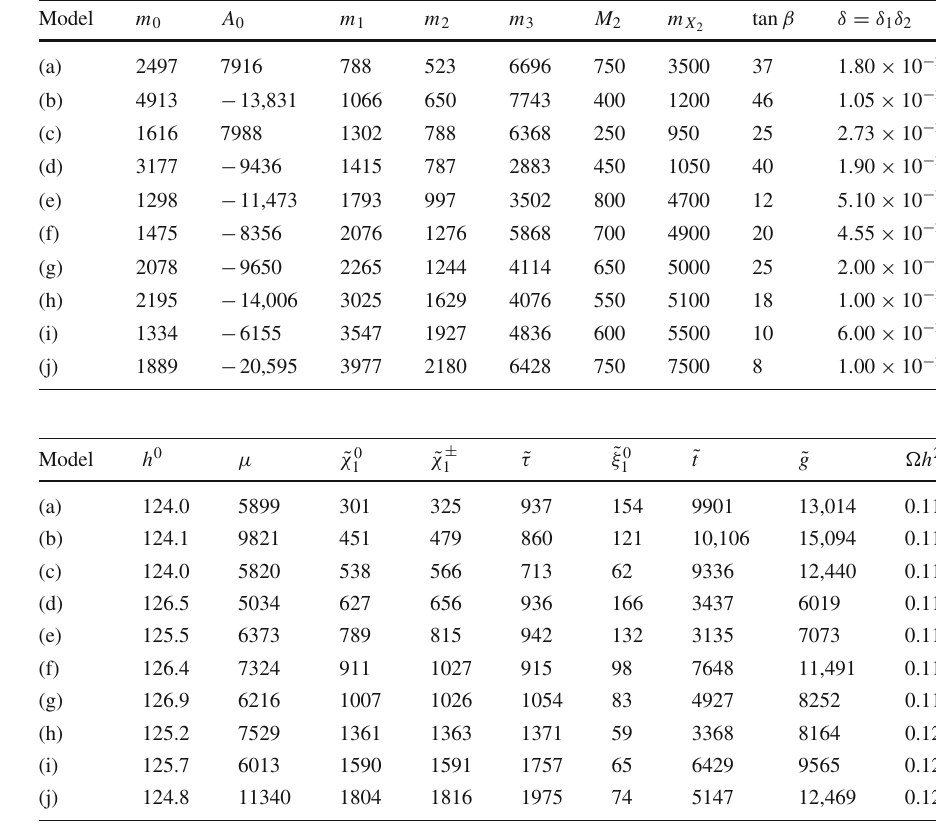
the photon energy are in GeV and the thermally averaged cross-section is in units of cm 3